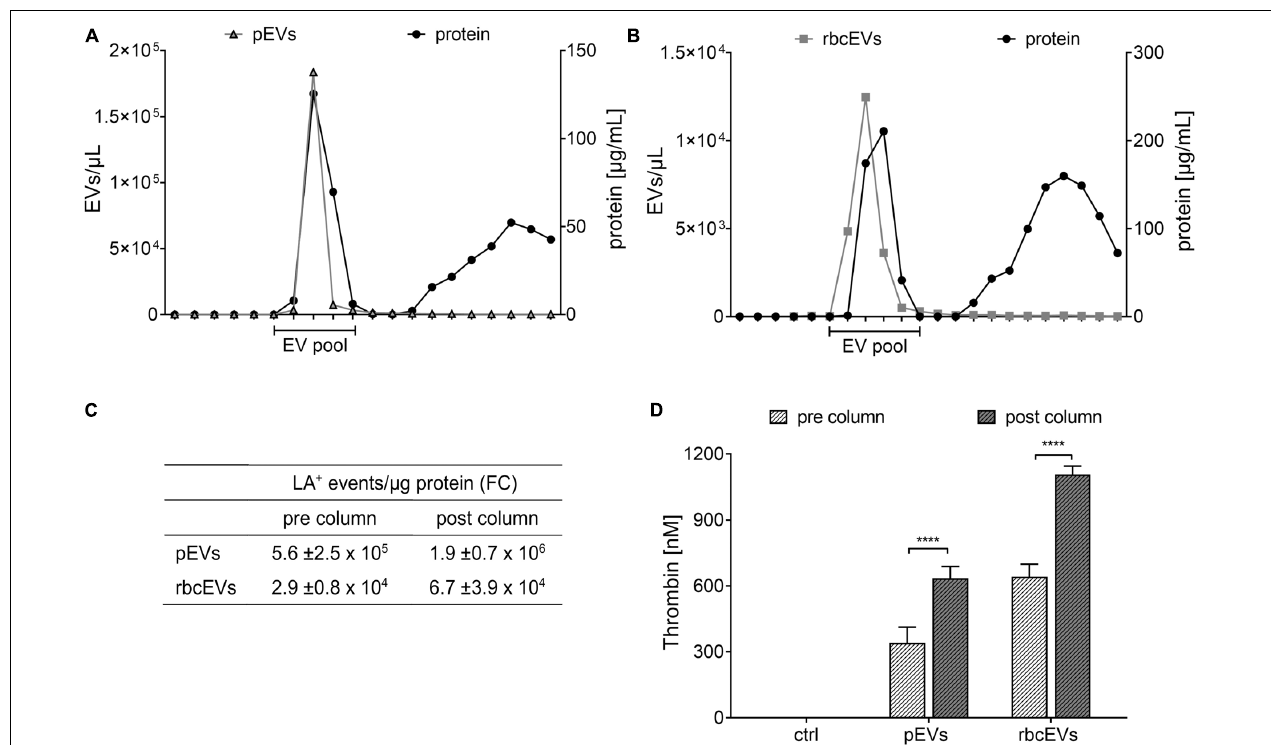
FIGURE 3 | Influence of soluble proteins co-enriched during isolation of extracellular vesicles on thrombin generation. (A) EVs isolated from medical grade platelet concentrates (pEVs) and (B) from red blood cell concentrates (rbcEVs) were separated from soluble co-enriched proteins by size exclusion chromatography (SEC), and EV-containing fractions were pooled and characterized as described in the section “Materials and Methods.” (C) EV counts (assessed by FC) normalized to protein content before and after size exclusion chromatography. (D) Thrombin generation induced by pEVs and rbcEVs before and after purification via size exclusion column chromatography ( n = 3); **** p ≤